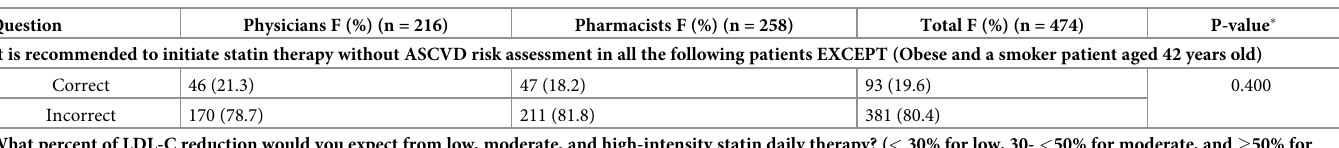
Table 2. Participants’ clinical knowledge about statin